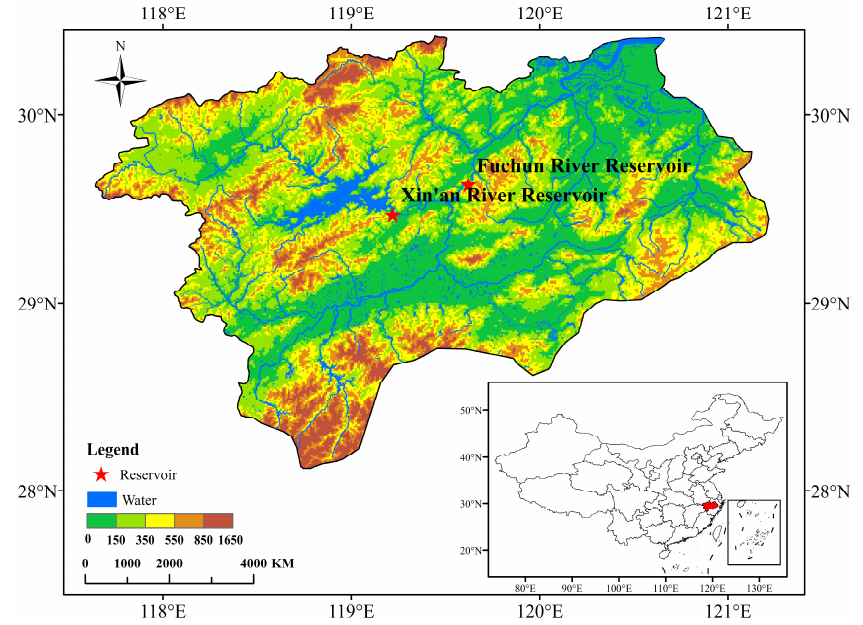
Figure 3. Location of the Qiantang River basin.